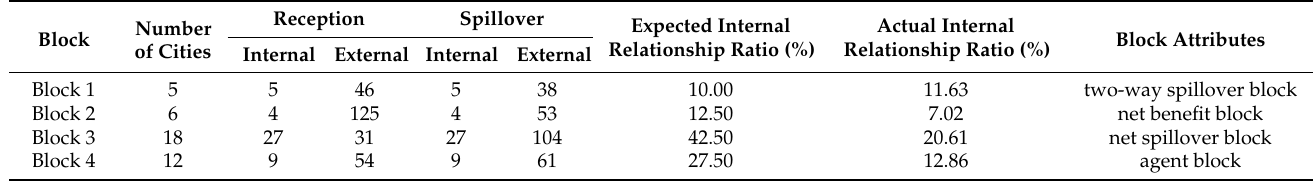
Table 5. Spillover effect of the spatial association blocks of tourism eco-efficiency in the Yangtze River Delta. Block